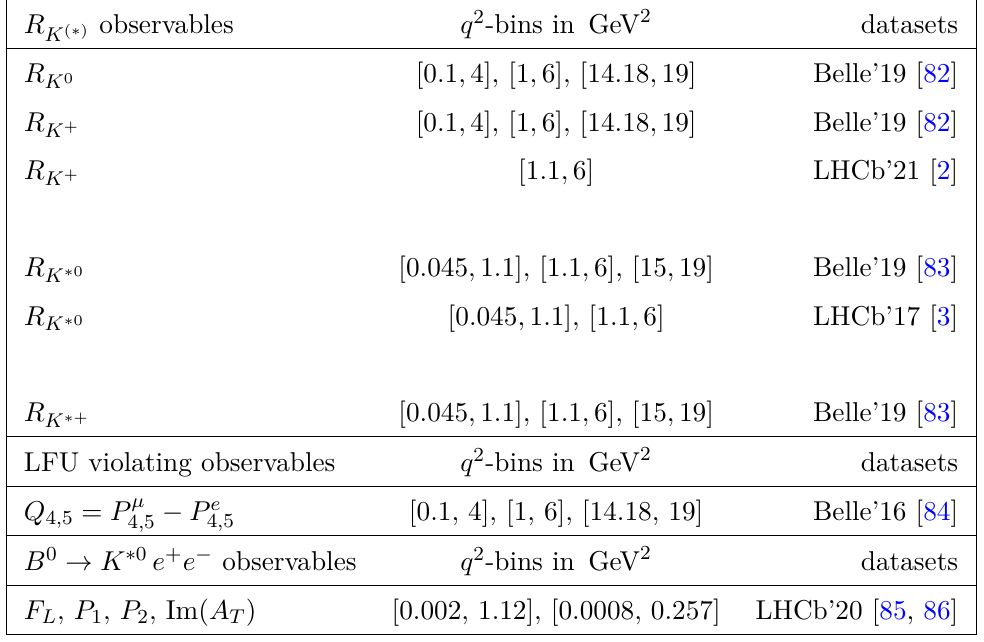
and B 0 → K ∗ 0 e + e − observables input for the global fit including R Table 8 . R K ( ∗ )